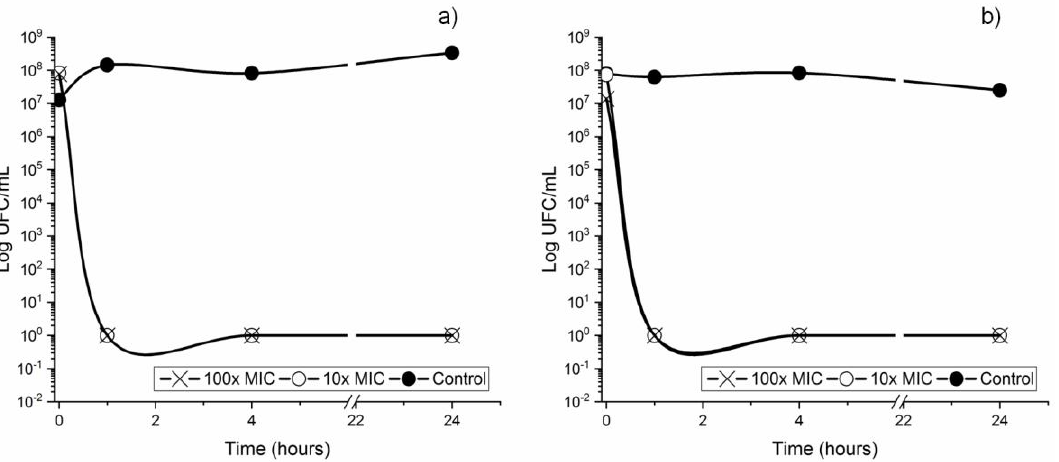
Figure 3. Time-kill curves for a standardized culture of S. mutans ( a ) and S. sanguinis ( b ) subjected to 10, 100 times their MIC and Control (no treatment) at different times.